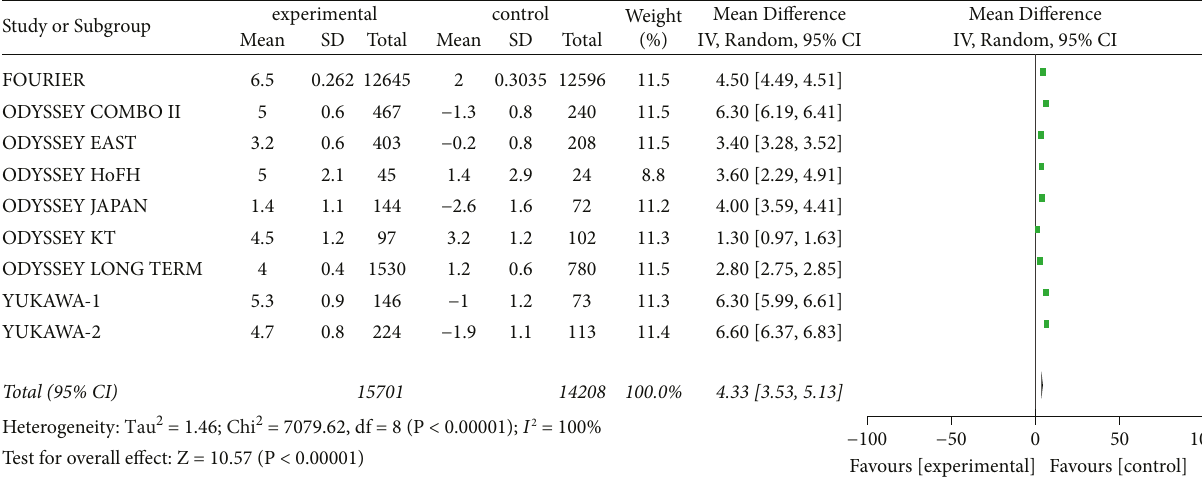
Figure 11: Comparison of the rise of serum ApoA1 (%) from baseline between control group and experimental